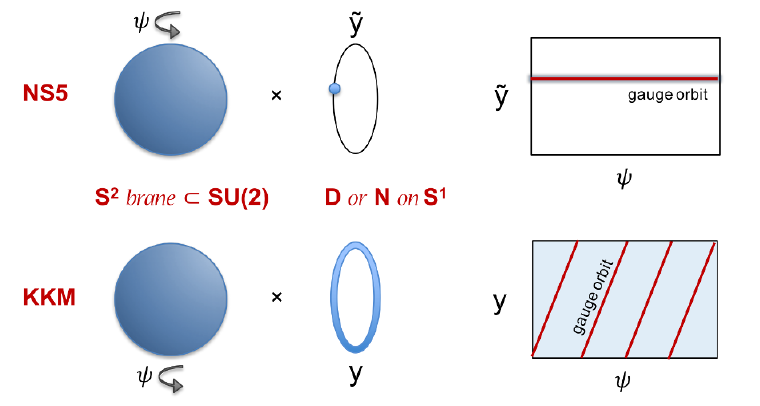
Figure 12. T-dual pictures of the W-brane. In the NS5-P frame in type IIB (top), D1-branes stretching between NS5’s lift to S 2 branes smeared along the temporal gauge orbit and are pointlike on the ~ y circle. In the type IIA NS5-F1 frame (bottom), the NS5 source becomes a coiled KK monopole loop; the W-brane is now a D2 wrapping a vanishing cycle of coincident KKM’s, and lifts to an S 2 (cid:2) S 1 brane extended along the T-dual y circle (and again smeared along gauge orbits). On the right, the spatial gauge orbits on the respective ~ y - and y - tori are depicted to